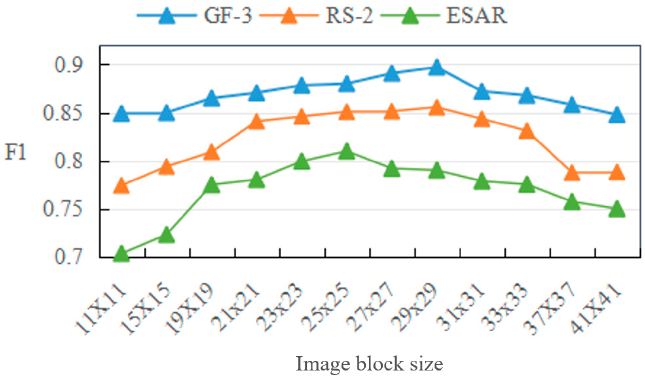
Figure 12. Accuracy of building extraction results under different image block sizes.